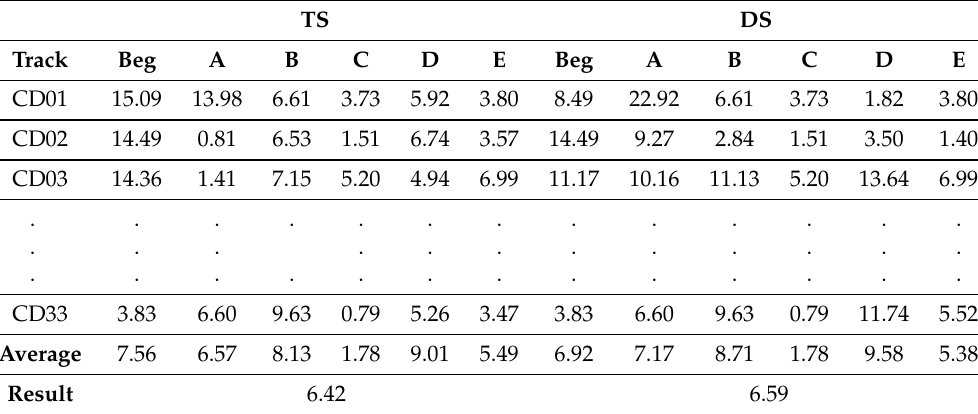
Figure 13. Visualisation of the GT computation—Ref, TS and DS estimation. Table 7. Differences between the estimated GT and the EAT for both